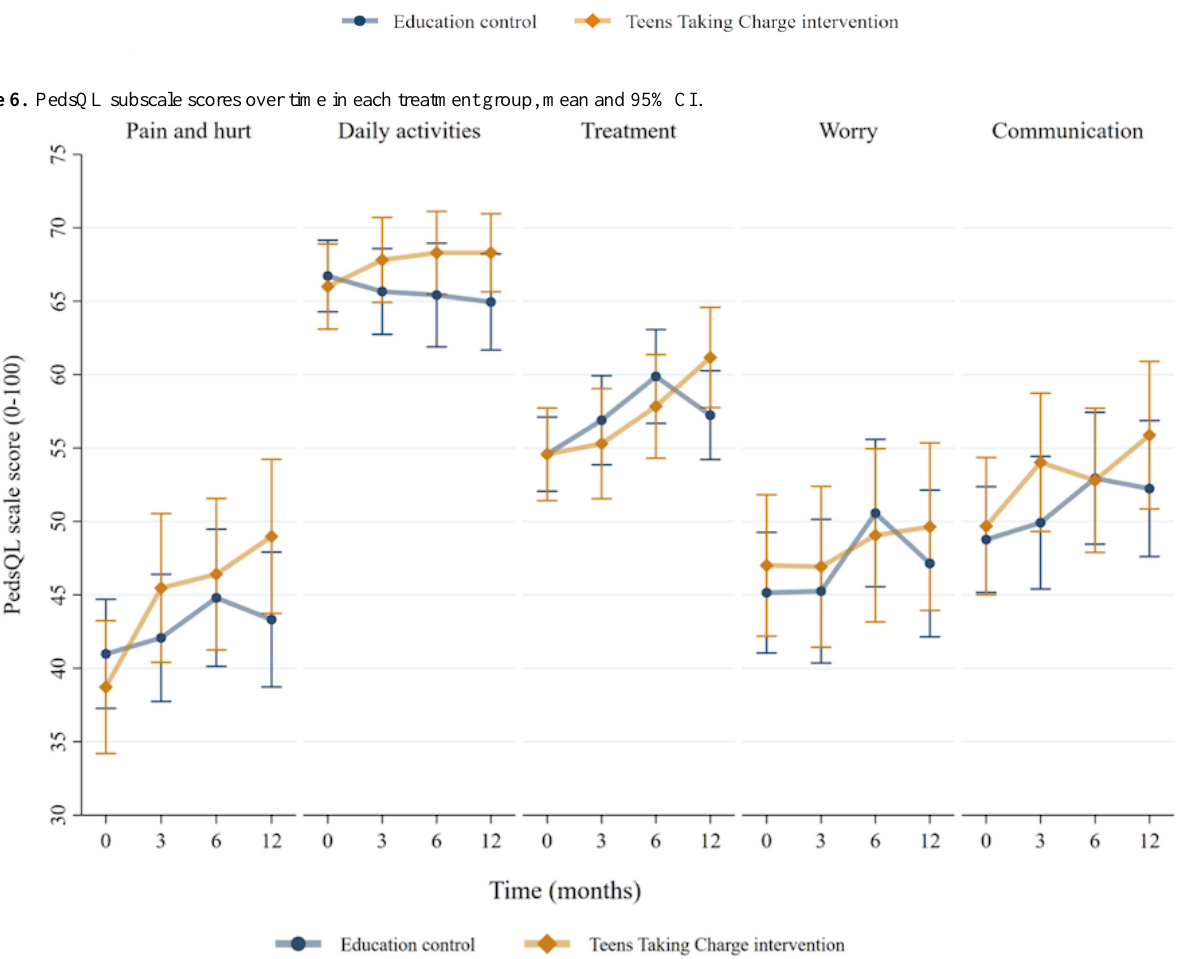
in Multimedia Appendices 6 and 7. There were no significant differences between study groups on primary and secondary caregiver